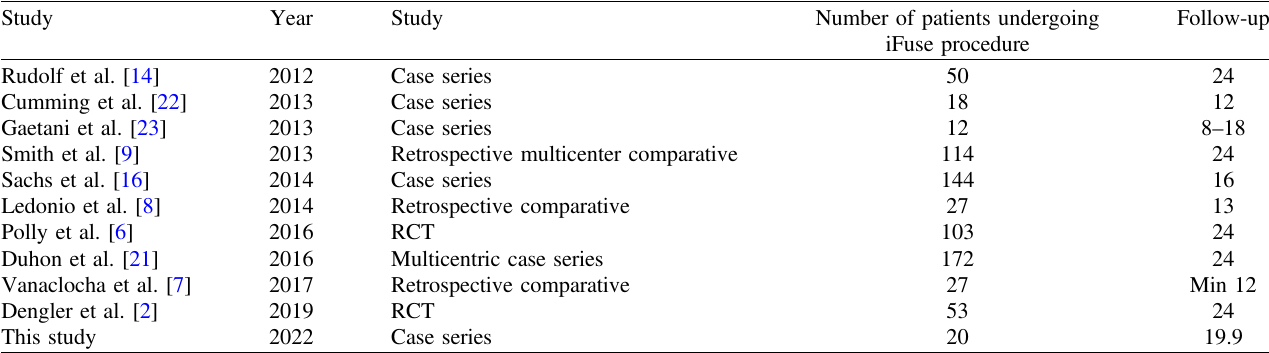
Table 1. Listing published work on MI SIJ fusion using iFuse (cid:1)